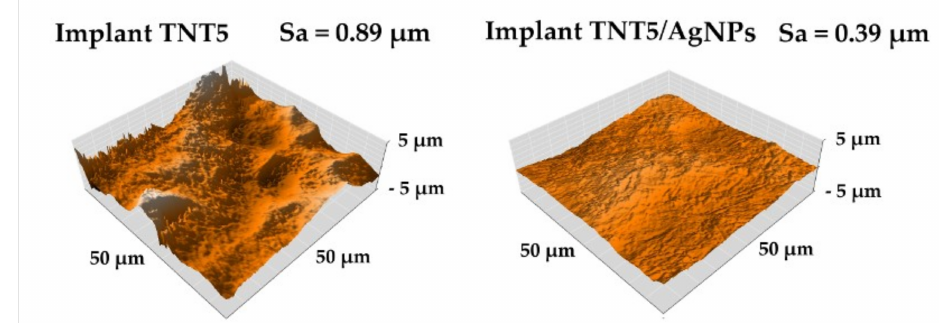
Figure 10. The topography of TNT5 and TNT5 / Ag implants with Sa (Average Roughness) parameter values, which was determined using atomic force microscope